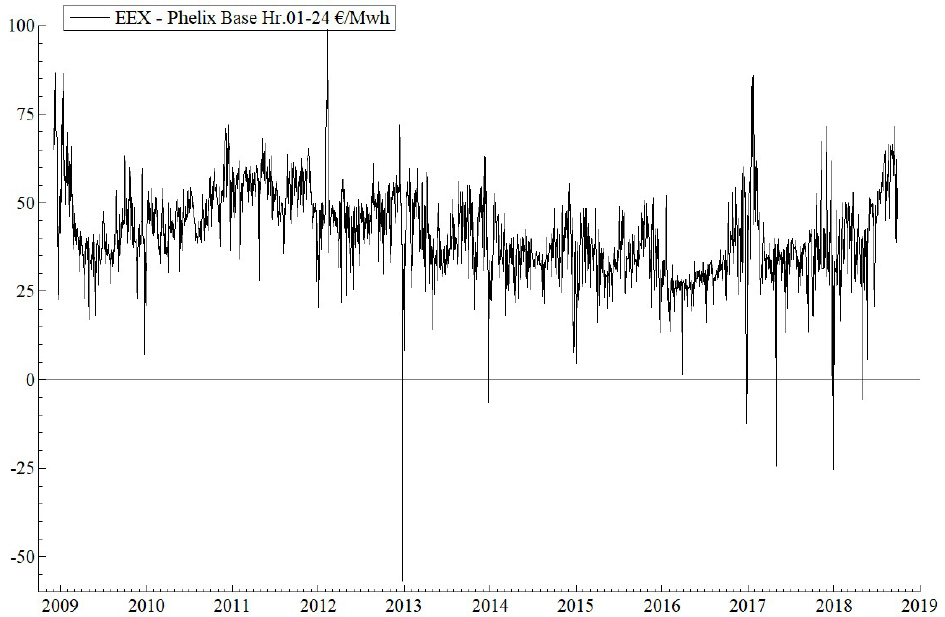
Figure 1. Daily European Energy Exchange (EEX) power future prices in Euro/Mwh, 2 December 2008 to 28 September 2018.